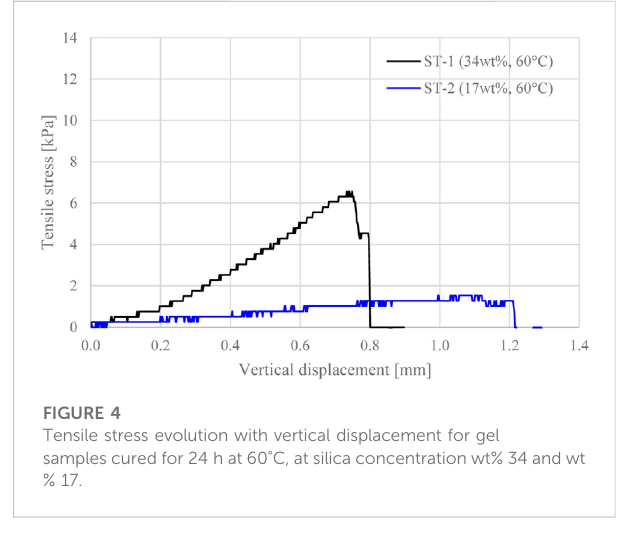
FIGURE 4 Tensile stress evolution with vertical displacement for gel samples cured for 24 h at 60 ° C, at silica concentration wt% 34 and wt % 17.